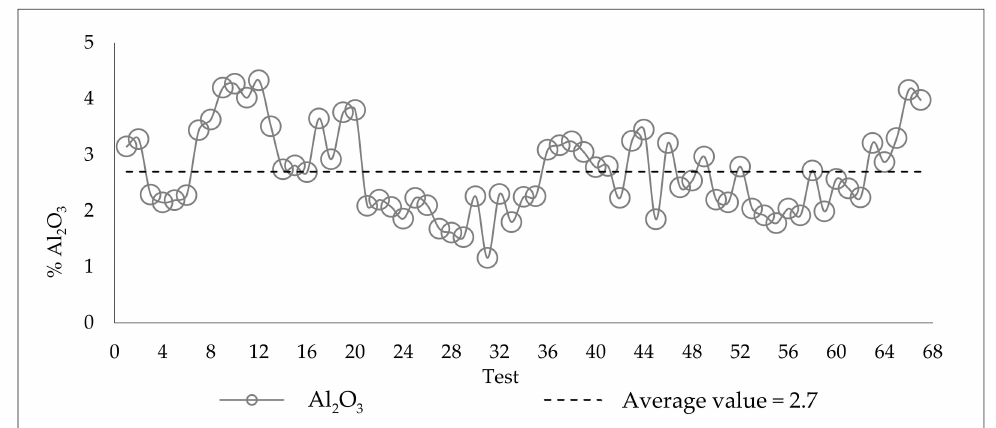
Figure 9. Variation of values concerning the Al 2 O 3 content in the flotation feed during the pilot tests.